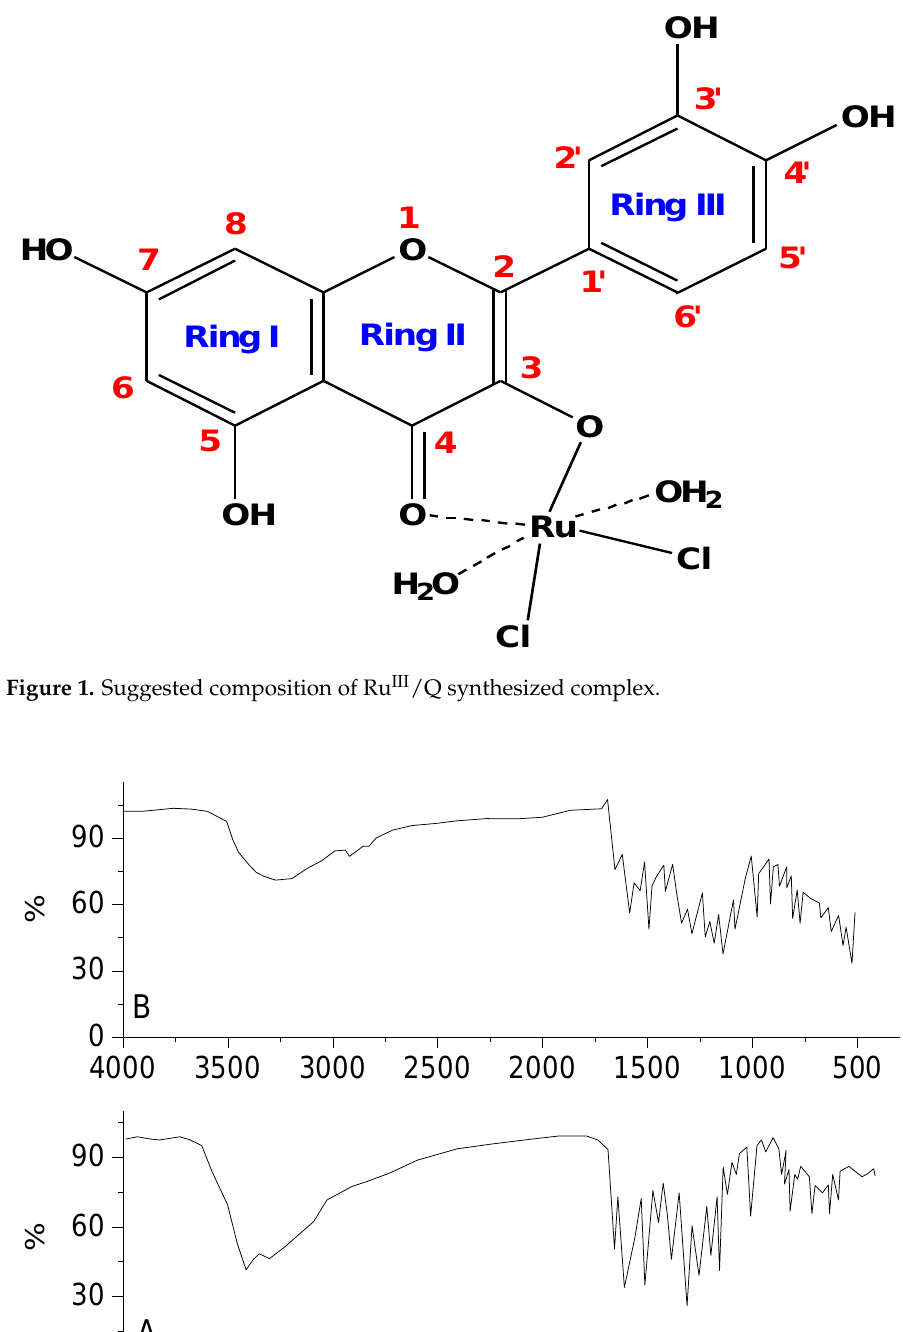
Figure 1. Suggested composition of Ru III /Q synthesized complex.